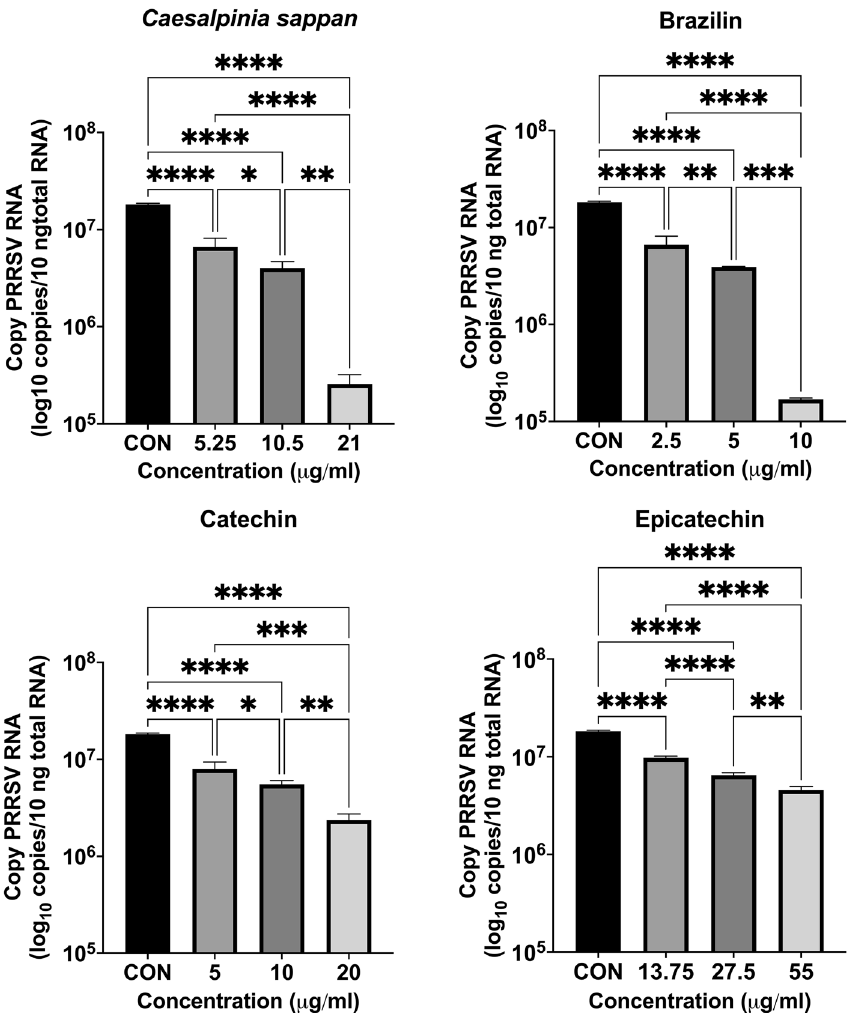
Figure 9. Intracellular PRRSV RNA release determined by real-time PCR of MARC-145 cells treated with Caesalpinia sappan extract, brazilin, catechin, and epicatechin for 1 h, then inoculated with PRRSV (MOI =